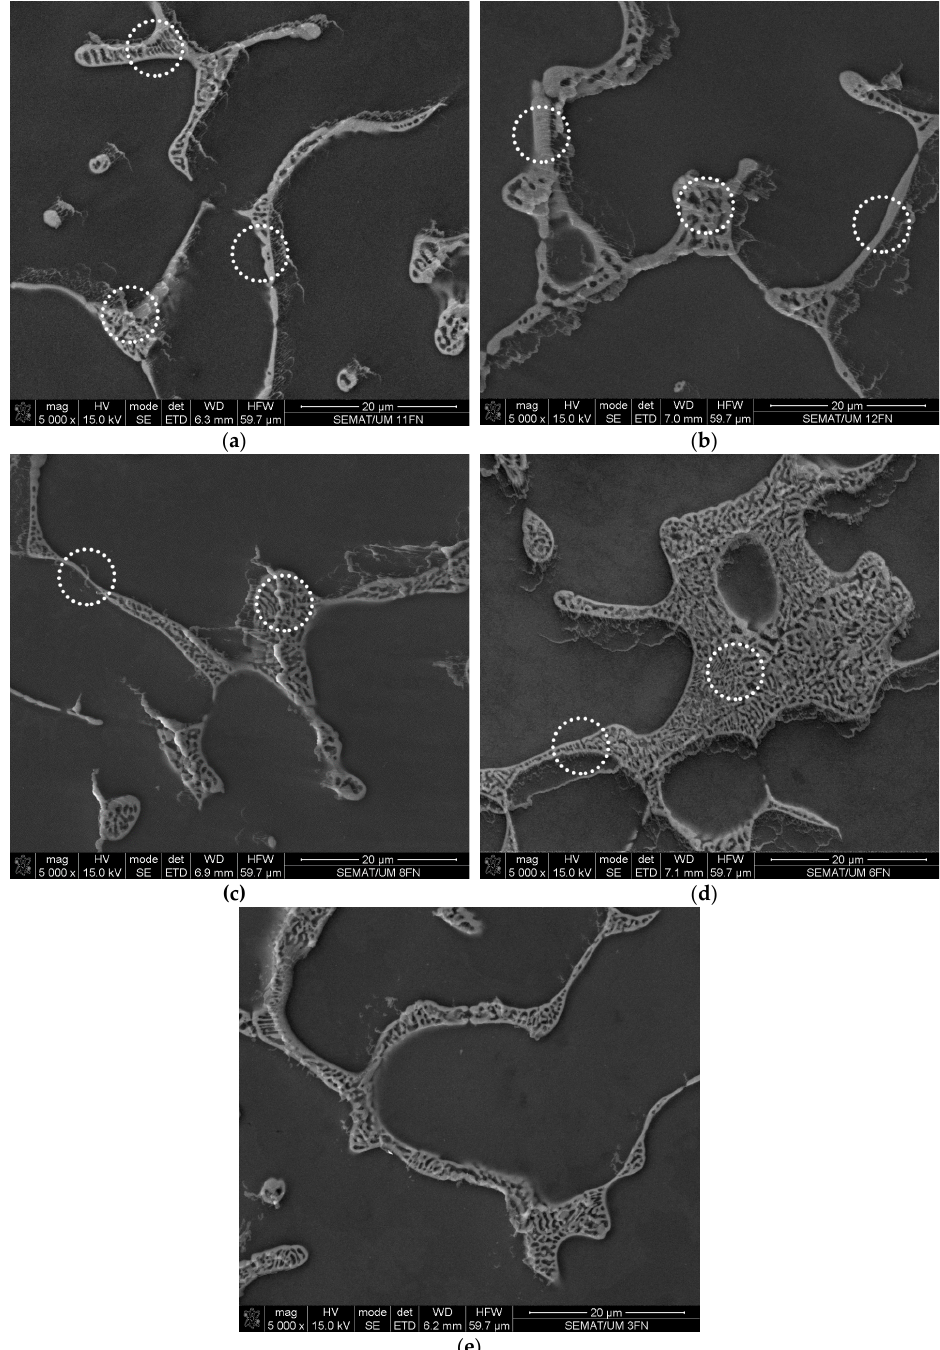
Figure 13. Microstructure of the produced alloys without chemical etching ( a ) batch 15M, ( b ) batch 45M, ( c ) batch 15U, ( d ) batch 45U, and ( e ) batch 90U. The USV-treated samples, as indicated the dotted circles, exhibited generally finer eutectic morphology.